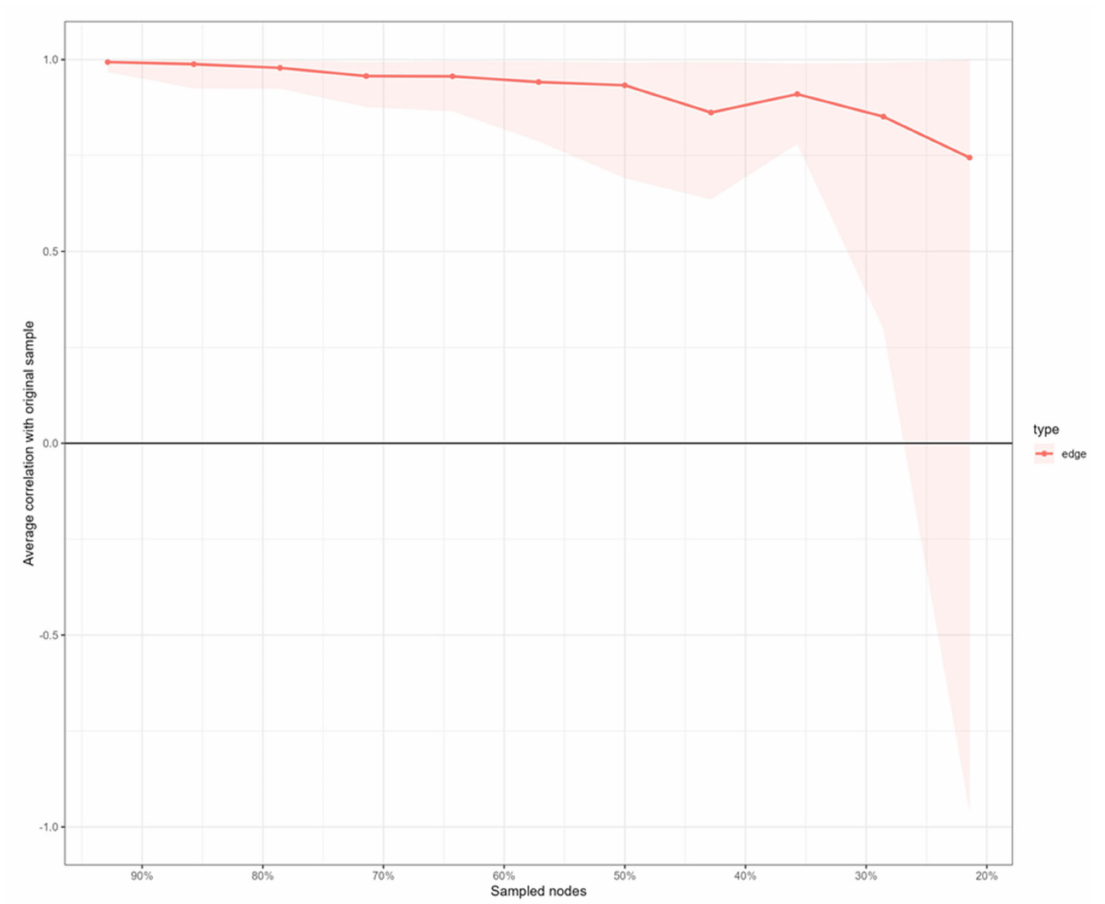
Figure 4. Stability of edges indices of the estimated